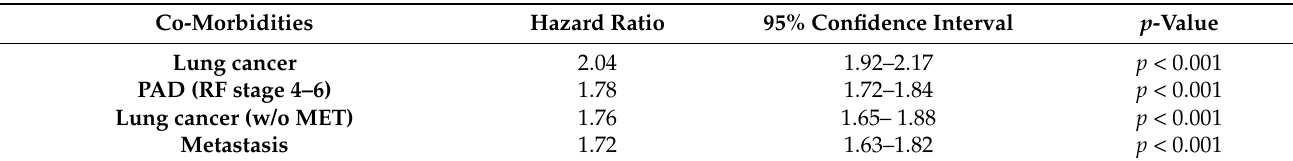
Figure 2. ( A , B ) Forrest plot of Cox regression analyses for predictors of all-cause mortality. ( A ) included all cancer patients with or without spread of metastases at baseline. Hypertension, dyslipidemia, obesity, previous MI, and skin cancer were protective comorbidities in STEMI patients. Comorbidities with markedly poor survival were lung cancer, PAD (4–6) and stroke. ( B ) is separated into metastases at baseline and cancer without metastasis. This shows that cancer without metastasis in STEMI has a smaller impact on mortality and that metastasis per se worsens survival. Abbreviations: AF/AFL, atrial fibrillation/atrial flutter; CABG, coronary artery bypass grafting; CHF, chronic heart failure; CKD, chronic kidney disease; CVD, cerebrovascular disease; MET, metastasis; MI, myocardial infarction; PAD, peripheral artery disease; PCI, percutaneous coronary intervention; w/o, without.